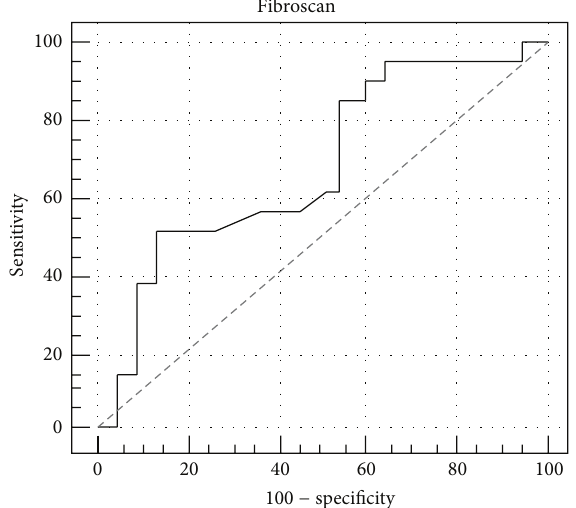
Figure 3: Accuracy of fibroscan in predicting endothelial dysfunc- tion.Sensitivity52%andspecificity86%.PPVequalto79%andNPV of 66% in predicting endothelial